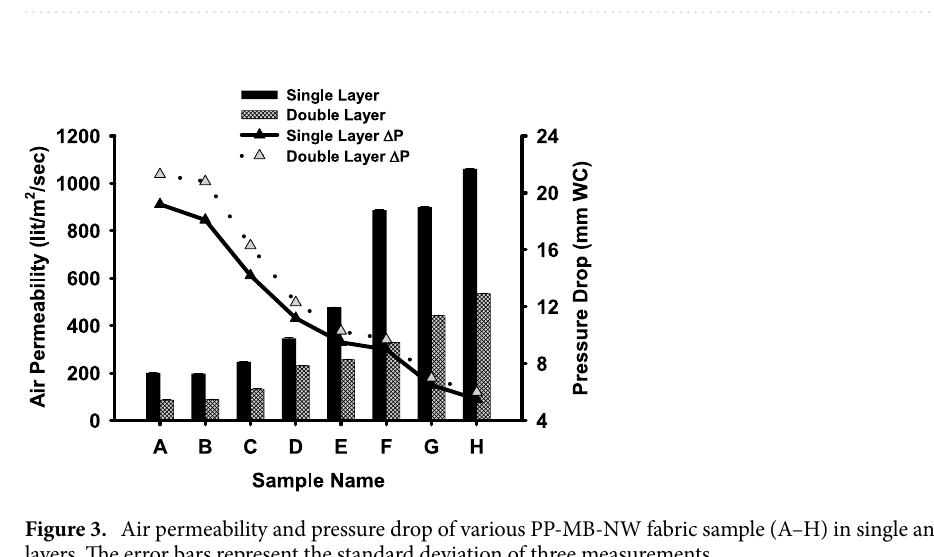
Table 1. Structural characteristic of PPE melt blown non woven.